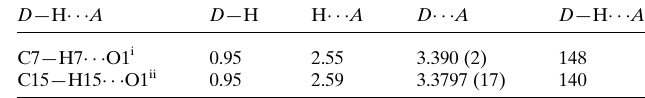
Table 1 Hydrogen-bond geometry (A˚ , (cid:4) ).